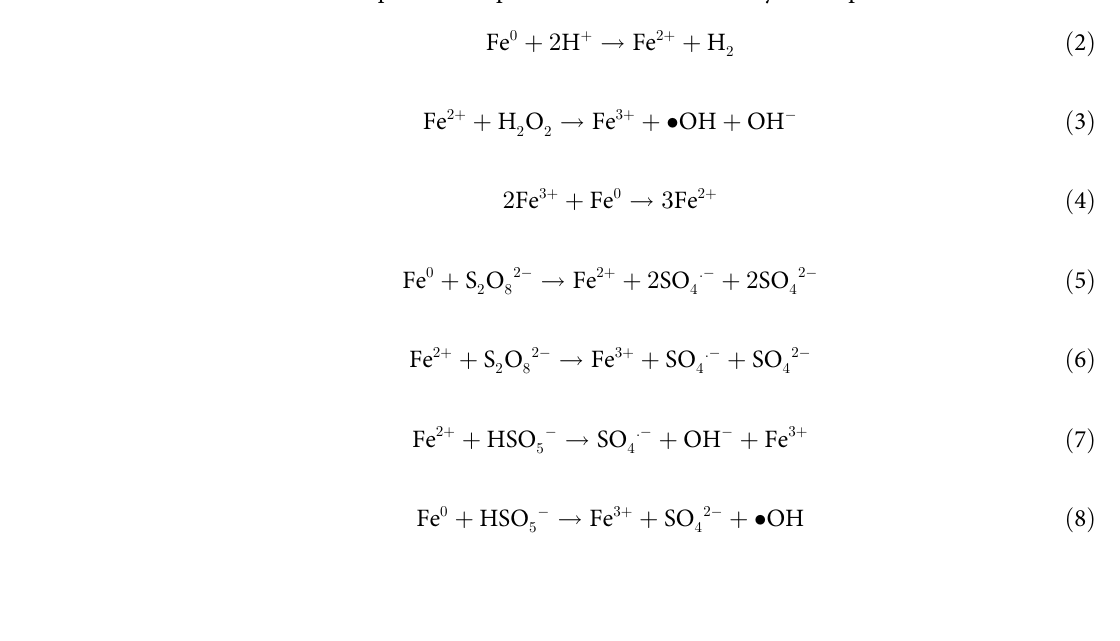
O , Fe 0 /PS and Fe 0 /PMS systems. The 2 2 O 2 2